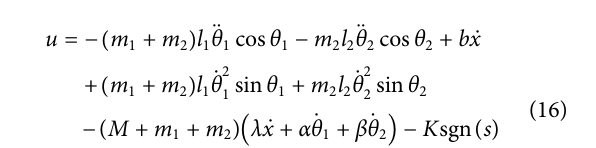
Frontiers in Robotics and AI |